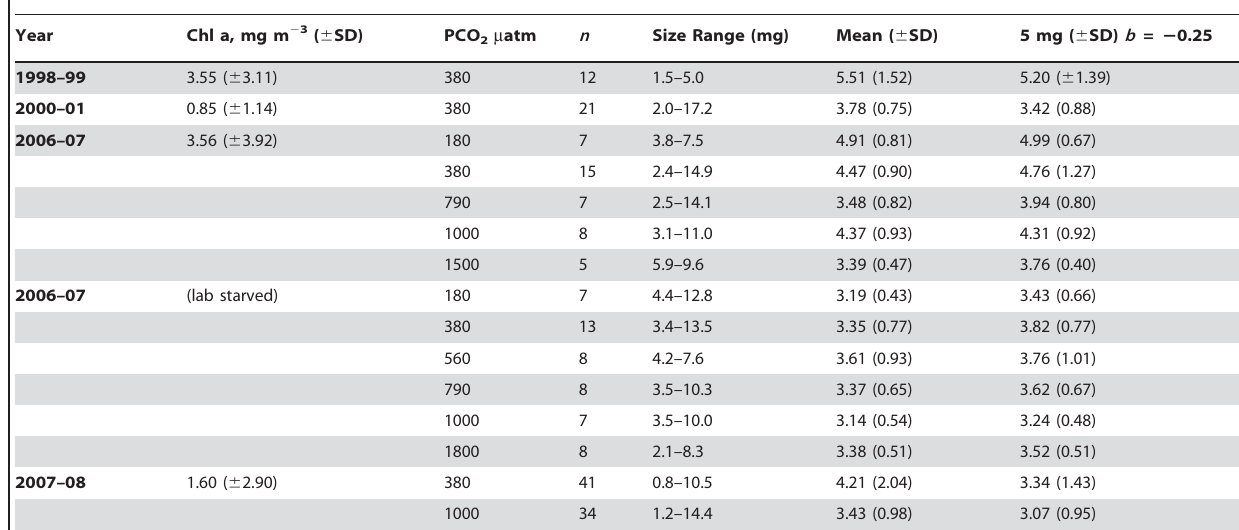
Table 1. Oxygen consumption rates (MO 2 , m moles O 2 g 2 1 h 2 1 ) of Limacina helicina antarctica in relation to carbon dioxide treatments presented as means and also normalized to a common body mass of 5 mg assuming a scaling coefficient ( b , MO 2 = b 0 M b ) of 2